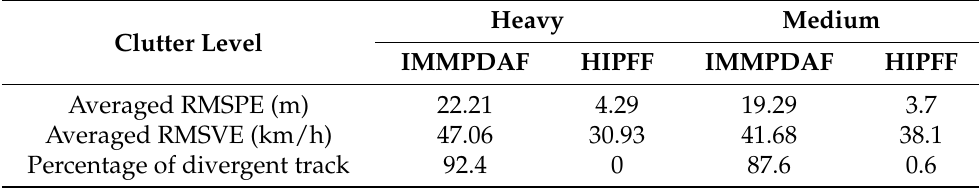
Table 3. MC simulation results under condition of v x ,0 = 80 km/h, d x ,0 = 100 m. Clutter